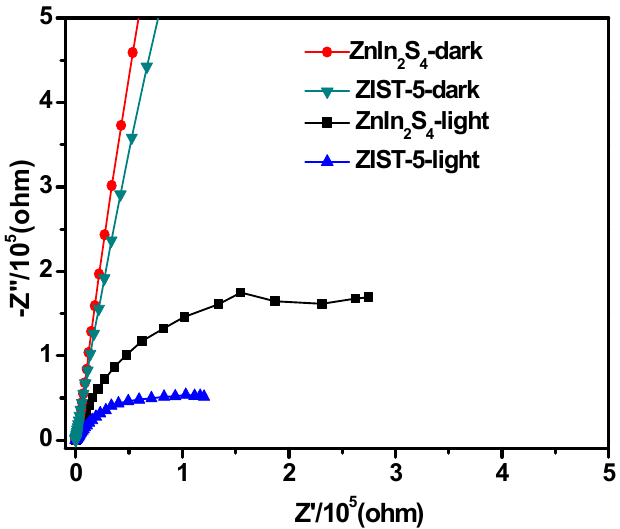
Figure 17. Nyquist plots of experimental impedance data for ZnIn 2 S 4 and ZIST-5 in the frequency range of 4 MHz to 10 MHz using an AC bias of 0 V vs. Ag/AgCl without or with visible light irradiation ( λ > 420 nm).